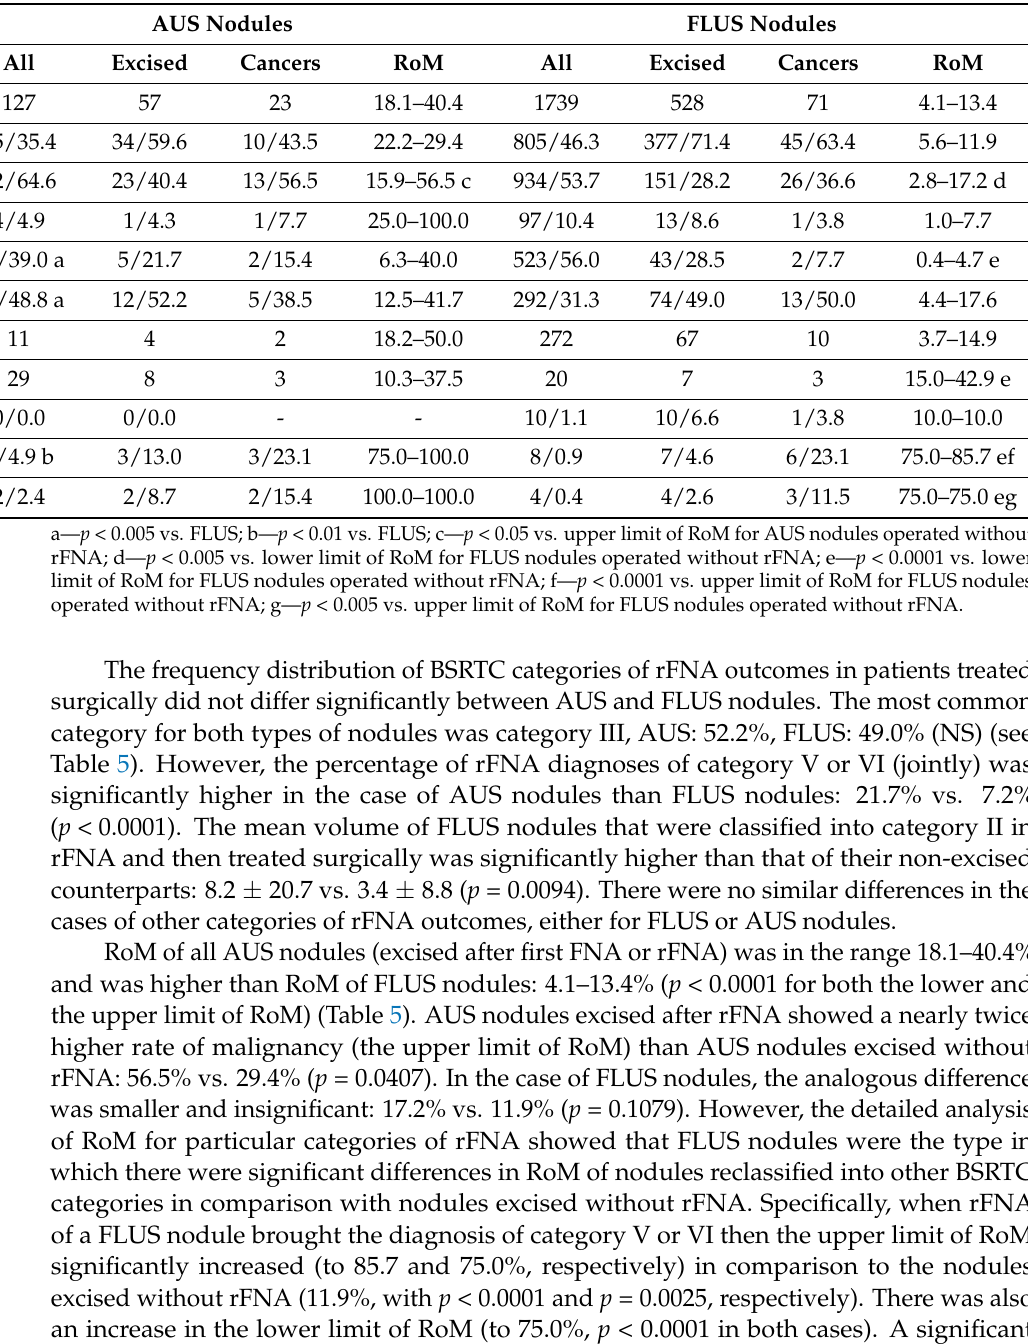
Table 5. Risk of malignancy (RoM) in AUS and FLUS nodules excised without or after rFNA, including its relation to the category of rFNA